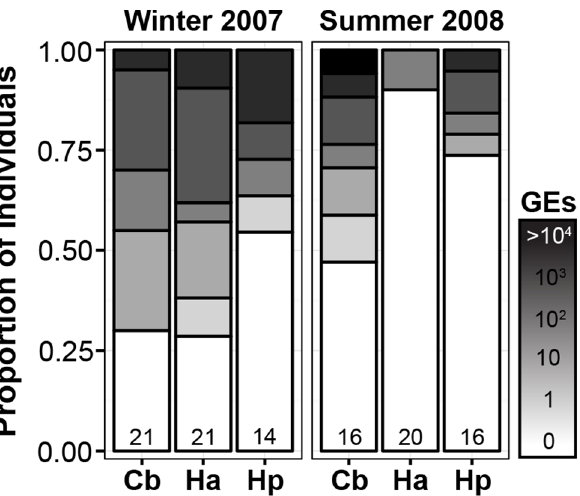
Fig 4. Intensity of Bd infection. Batrachochytrium dendrobatidis infection intensity of Cycloramphus boraceiensis (Cb), Hylodes asper (Ha) and Hylodes phyllodes (Hp) during winter and summer stream surveys at Parque Estadual da Serra do Mar, Brazil. The total number of individuals swabbed is shown in the bottom of each bar. We measured genomic equivalents (GEs) using qPCR, and report the proportion of individuals infected by each zoospore category: 0, 1 – 10, 11 – 100, 101 – 1000, and > 1001